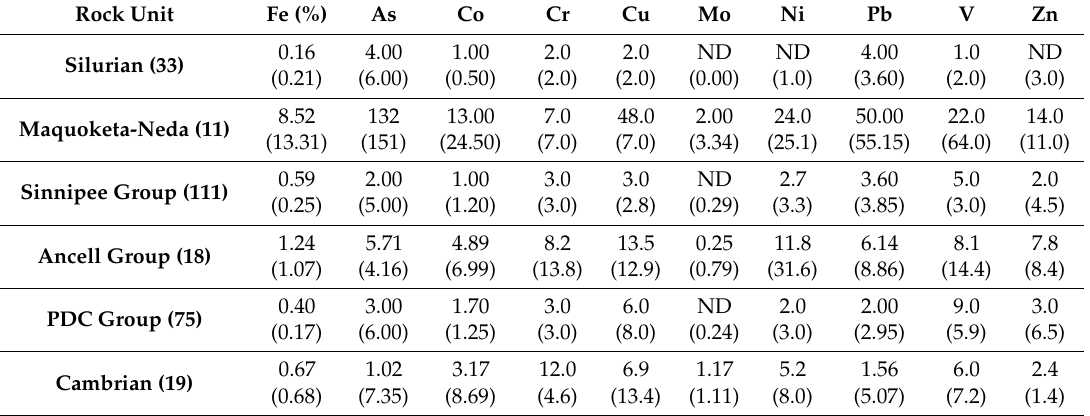
Table 4. Median metal concentrations (interquartile range in parentheses) for matrix samples from Paleozoic rock strata of northeastern Wisconsin (sample sizes in parentheses next to strata names). For Fe, the unit is percentage, while all other elements are measured in mg/kg (ppm). A Precambrian data point was excluded from this table due to having only one observation in that geologic